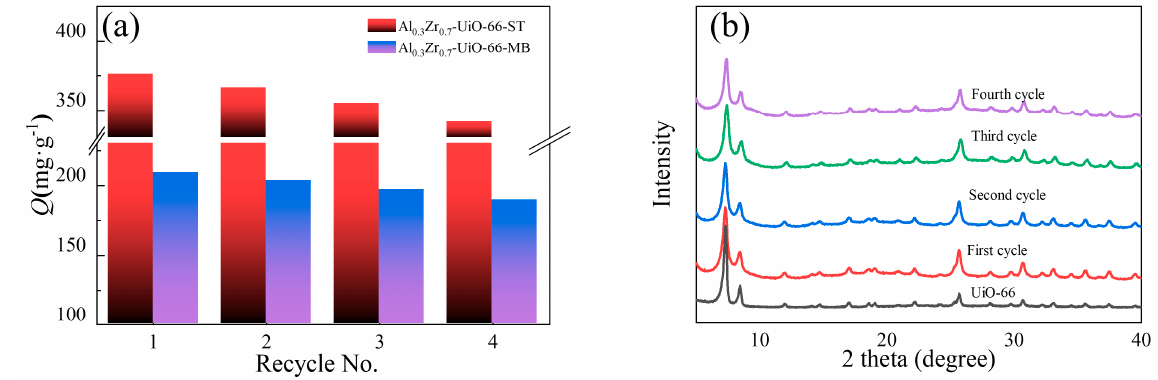
Figure 10. ( a ) Four-cycle ST and MB adsorption on Al 0.3 Zr 0.7 -UiO-66; ( b ) XRD patterns of Al 0.3 Zr 0.7 - UiO-66 after each cycle.